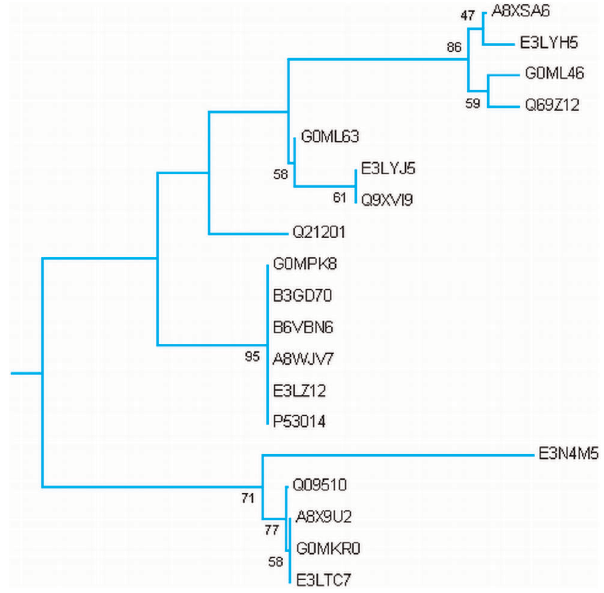
Figure 5. Group I. Tree showing all proteins included in this group.